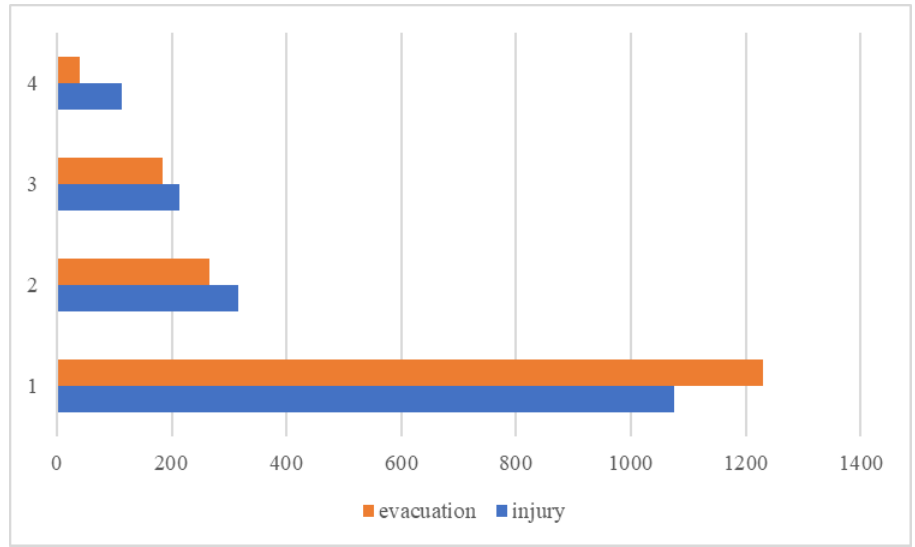
Figure 3. Frequency of reported Hazmat transportation accidents in each injury and evacuation severity category.